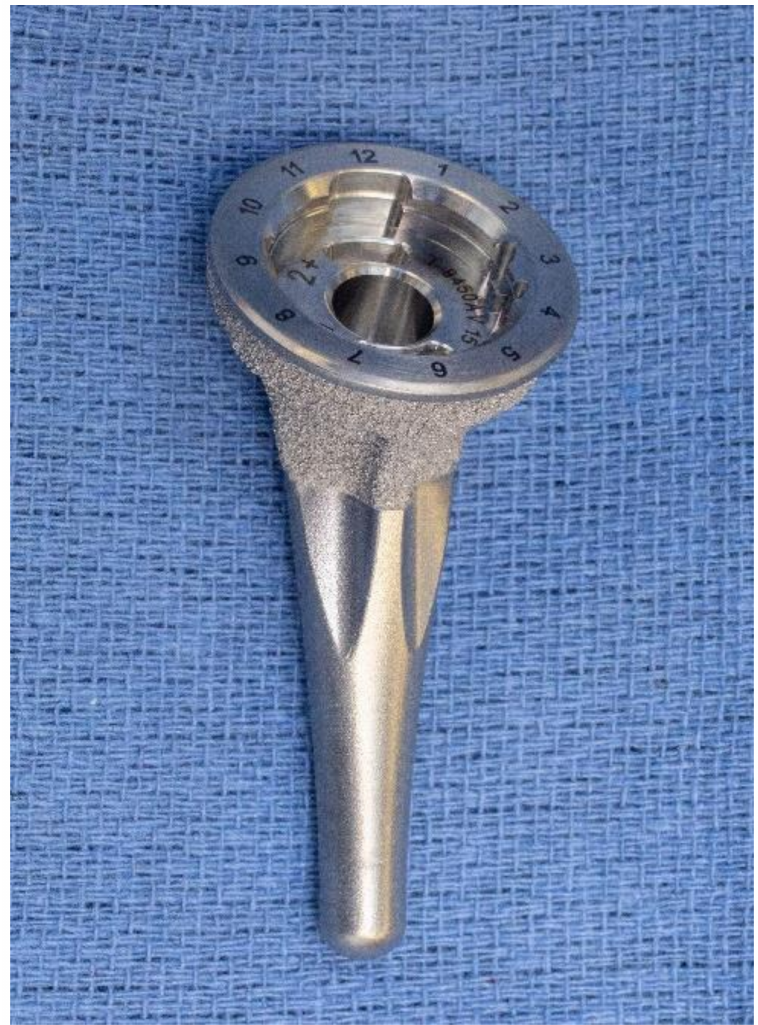
Figure 6. Contemporary platform of a short-stem humeral component designed for proximal fixation and